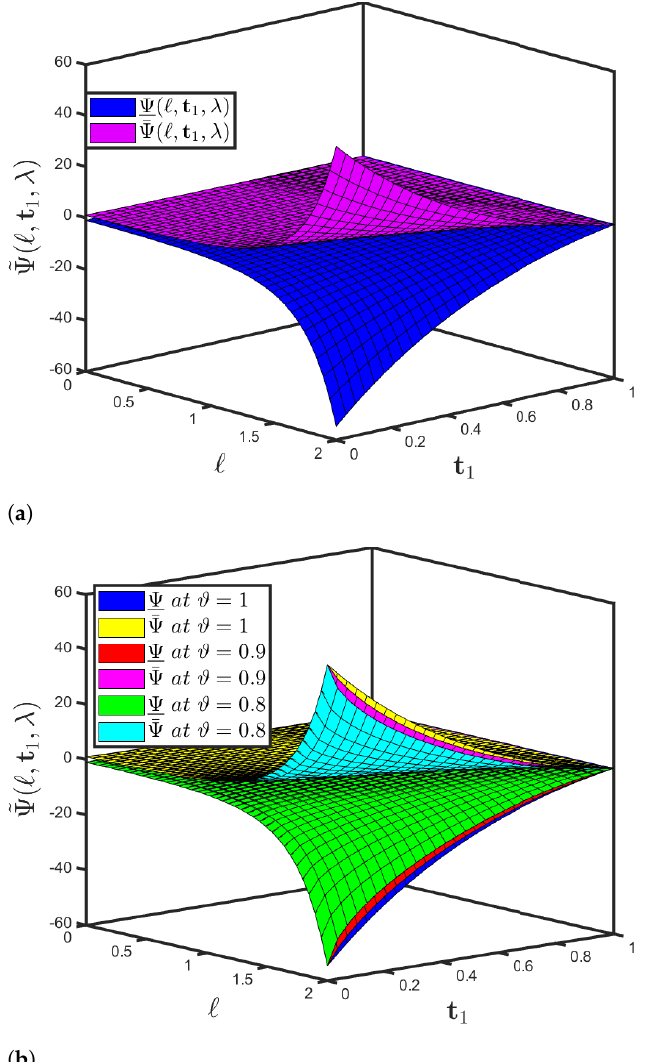
Figure 5. Three-dimensional plot of ˜ Ψ ( (cid:96) , t 1 ; λ ) of Problem (2): ( a ) Ψ ( (cid:96) , t 1 ; λ ) and ¯ Ψ ( (cid:96) , t 1 ; λ ) when ϑ = 1; and ( b ) Ψ ( (cid:96) , t 1 ; λ ) and ¯ Ψ ( (cid:96) , t 1 ; λ ) when the uncertainty parameter λ ∈ [ 0,1 ] has different fractional